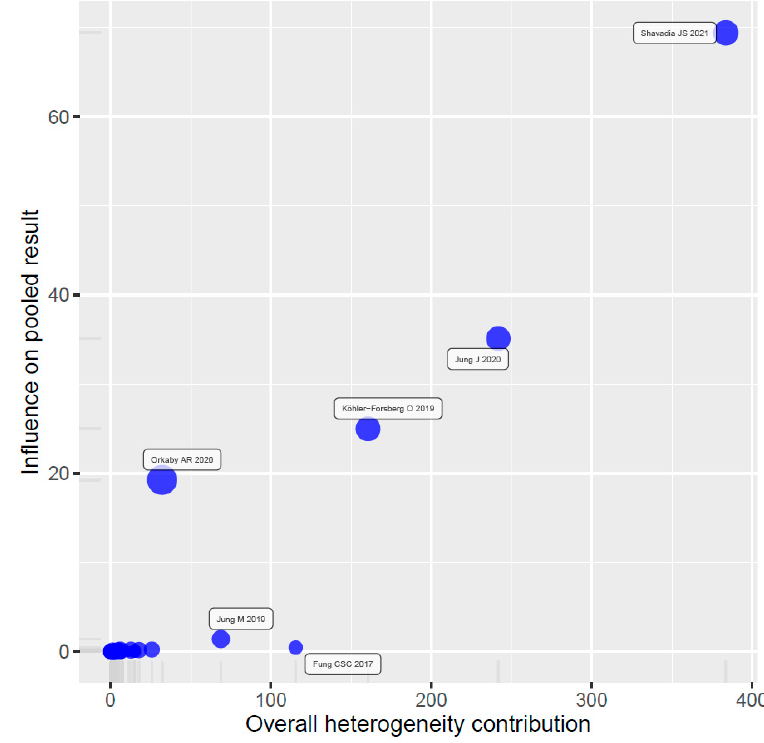
Figure 4. Baujat plot for the analysis of influential studies.